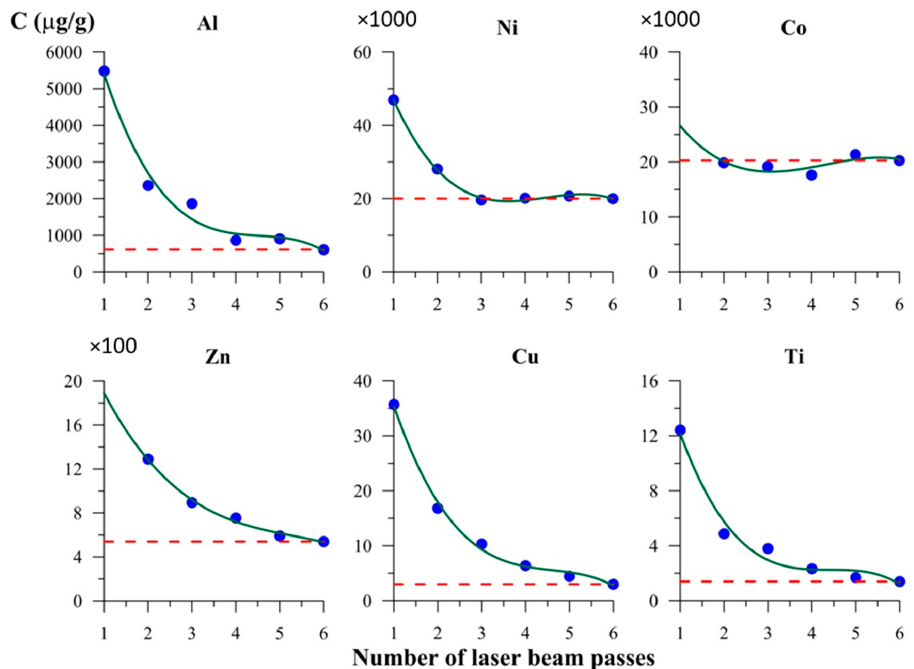
Figure 7. Elements content in the course of layer-by-layer LA-ICP-MS analysis of crystal surface. Magnetite crystal from Experiment 5 (Tables 1, A1). Figures 8 and 9 show the fractal character of surficial objects distribution in the surficial layer of magnetite crystals. The heights of surficial objects relative to the surface area of minimal roughness rarely exceeded 100 nm (Figure 9).